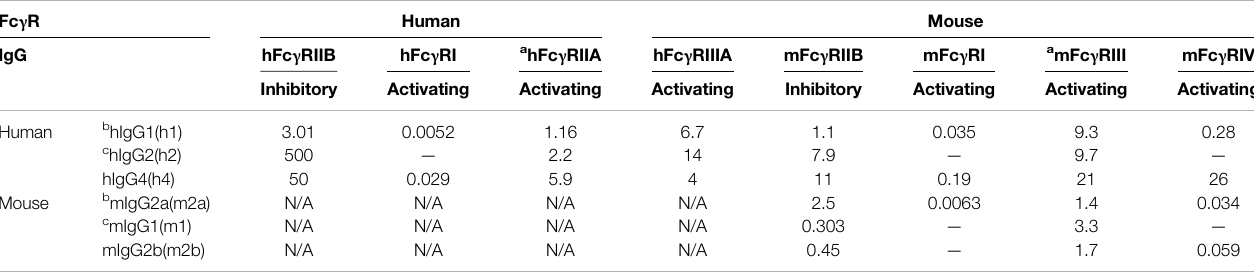
TABLE 3 | Af fi nity in KD ( μ M) of human and mouse IgG subclasses for Fc γ Rs. Fc γ